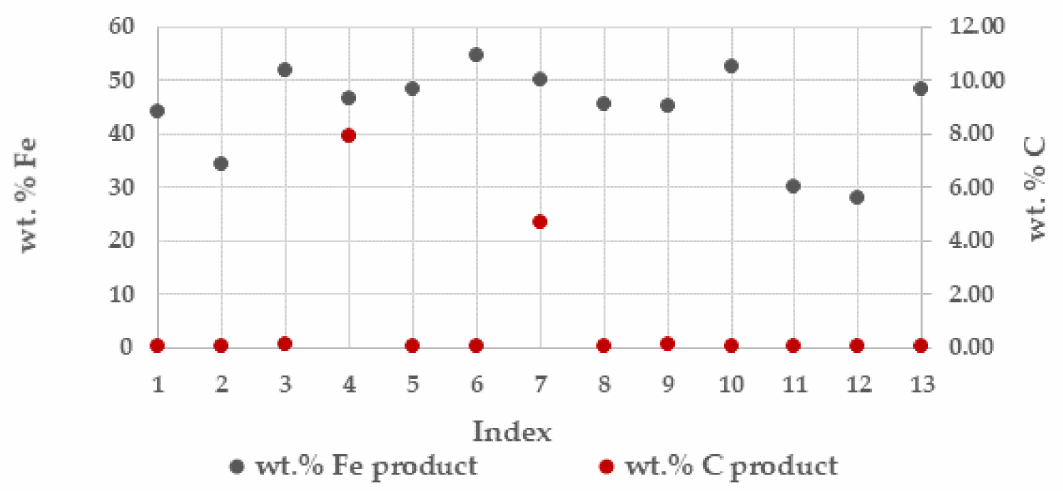
Figure3. Wt. %iron(Fe)andcarbon(C)inthesinterproductfromrespectivebatchesduringthecampaigns.